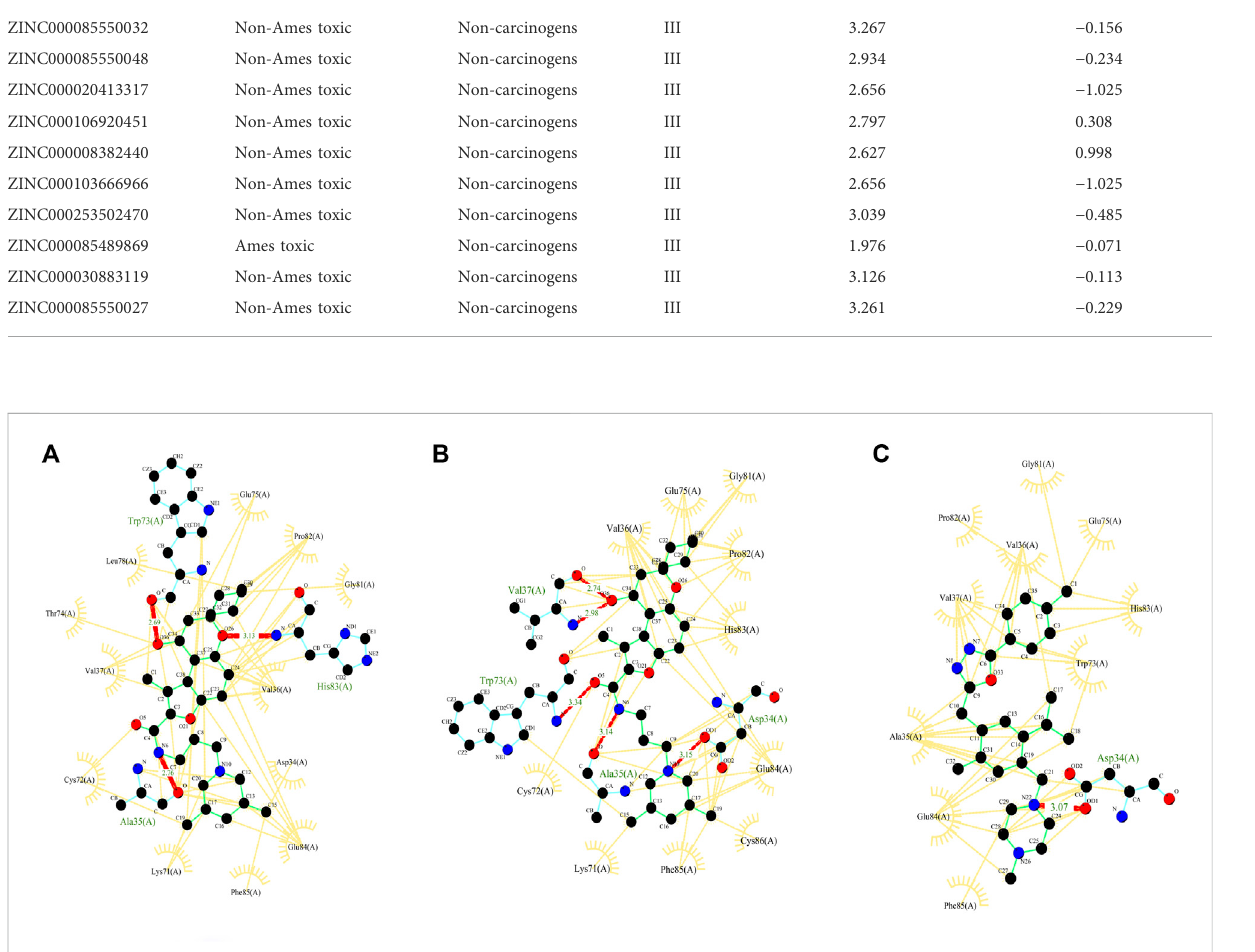
FIGURE 5 Figure showing the 2D interaction patterns (hydrogen bonds and hydrophobic interactions) of three selected complexes – molecules (A) ZINC000103666966, (B) ZINC000020413317 and (C)